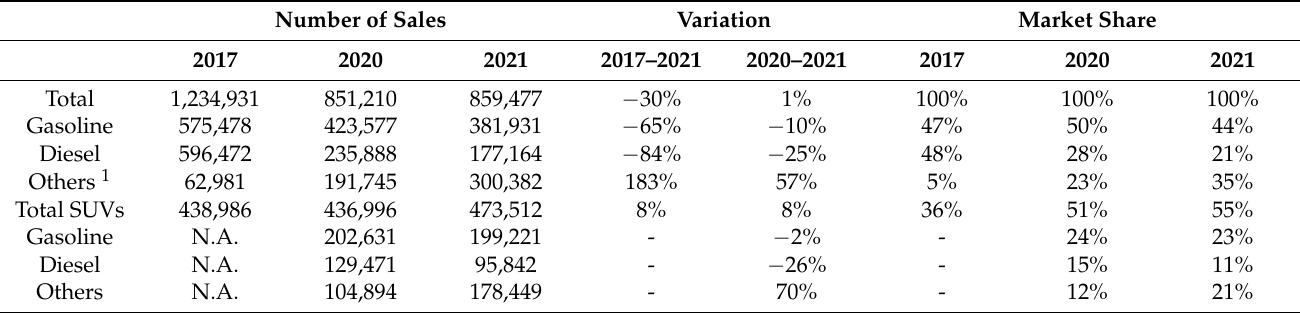
Table 1. Vehicle registrations in Spain by segment and combustible